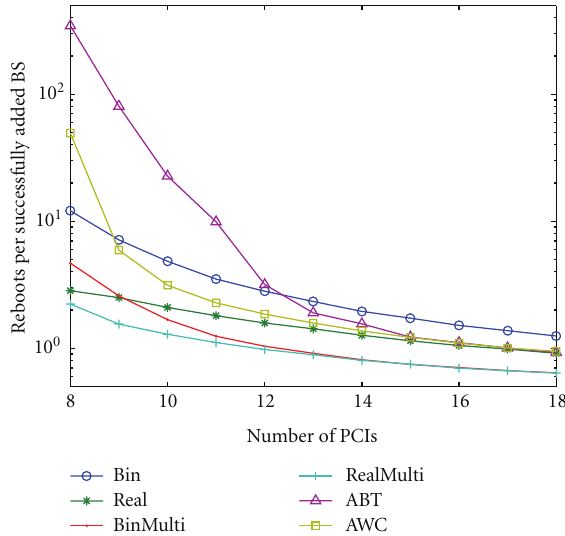
Figure 6: The number of cell reboots versus number of PCIs for di ff erent autonomous PCI configuration algorithms (only converged drops